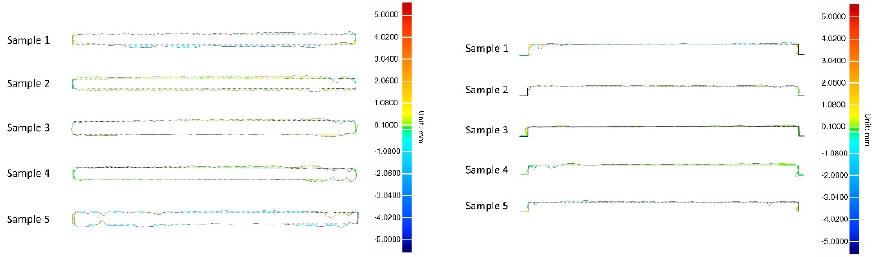
Figure 8. The degree of deviation of the cross-section and the longitudinal-section of each specimen. Whether in the cross section or the longitudinal section, the volatility of the profile curve is higher in specimen 1 and specimen 5, and lower in the specimens with moderate heat input. In specimen 4, although the error between its cross section and the ideal cross-section is smaller than that of specimen 5, the profile curve of its longitudinal section gradually deviates from the horizontal direction from the beginning to the end, and has experienced a gradual increase. This not only reflects the high degree of influence of height on the standard deviation and root mean square value, but also provides a good explanation for the abnormal changes in the standard deviation and root mean square value of specimen 4 in Figure 7. In specimen 2 and specimen 5, there is little difference in longitudinal cross-section. Although the overall deviation of specimen 2 from the ideal model cross-section is relatively high, the fluctuation of its profile is much smaller.